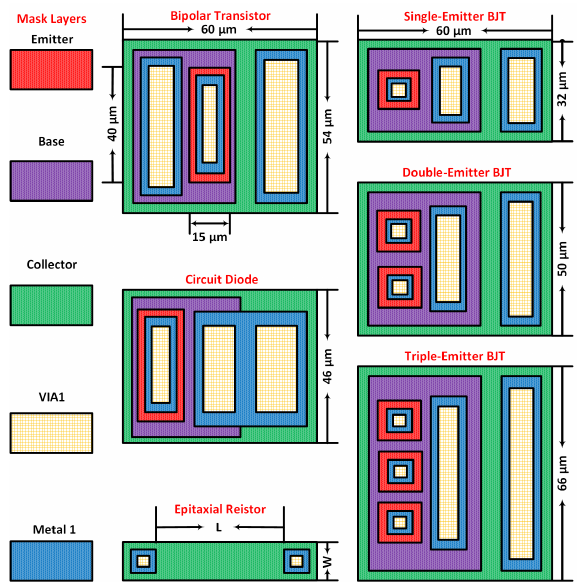
Figure 2. The PDK devices P-cells with PDK layers and vias. The multi-emitter bipolar transistors P-cells configured to single-emitter, double-emitter, and triple-emitter are shown on the right hand side respectively. The bipolar transistor circuit diode is made by shortening the base and collector terminals. The epitaxial integrated resistor has its width “W” fixed and the length “L” is parametrized to get the required resistance. The legend for the mask layers and vias are shown on the left hand side.